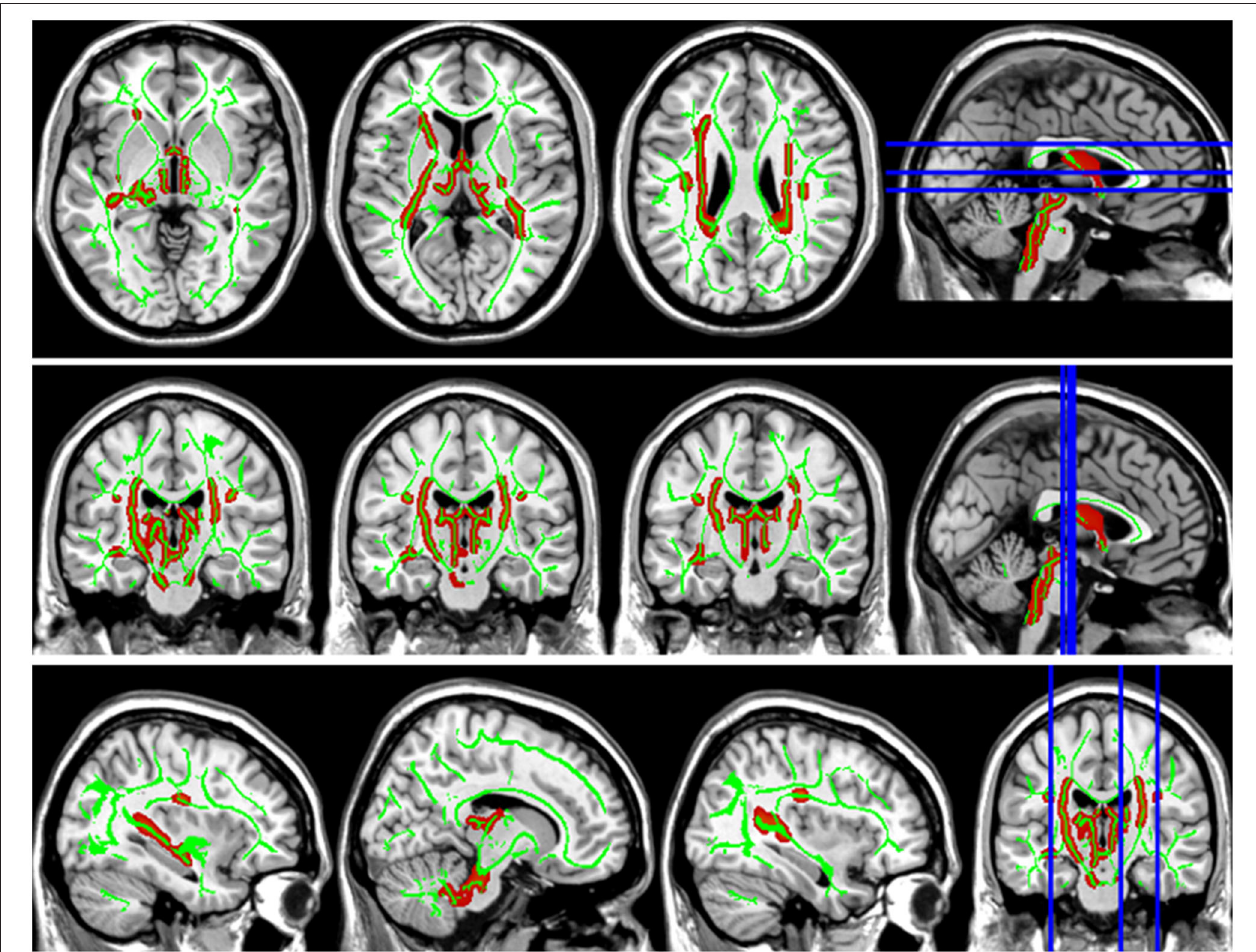
FIGURE 3 | Group differences in axial diffusivity (AD). The AD values in patients with LAN and RAN increased in bilateral superior longitudinal fasciculus, left anterior thalamic radiation, and right corticospinal